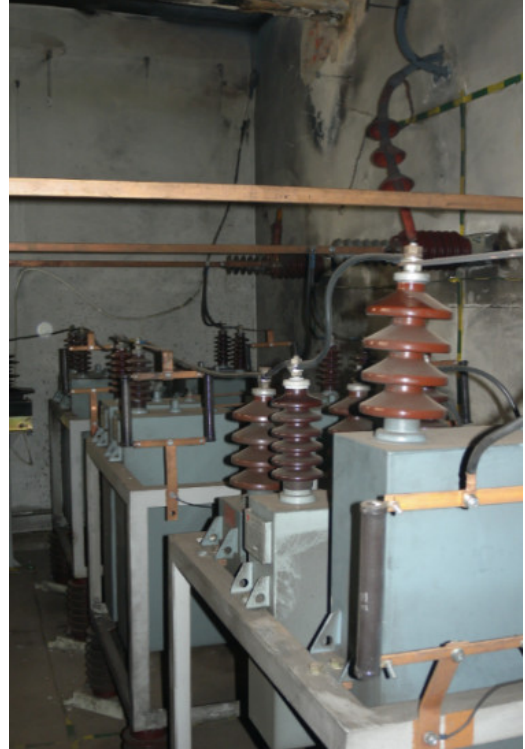
Figure 11. Damaged capacitor battery used to compensate for the reactive power of the arc furnace.